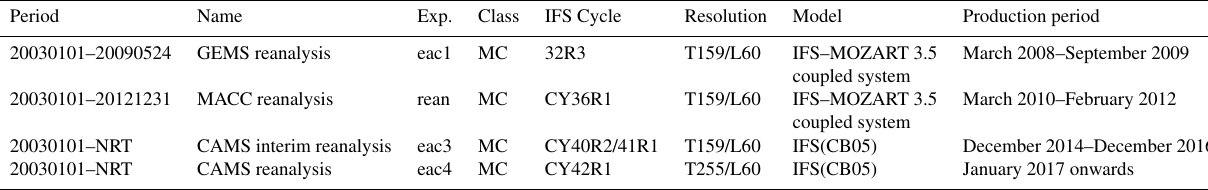
Table A2. Reanalyses of atmospheric composition produced with the GEMS–MACC–CAMS system.